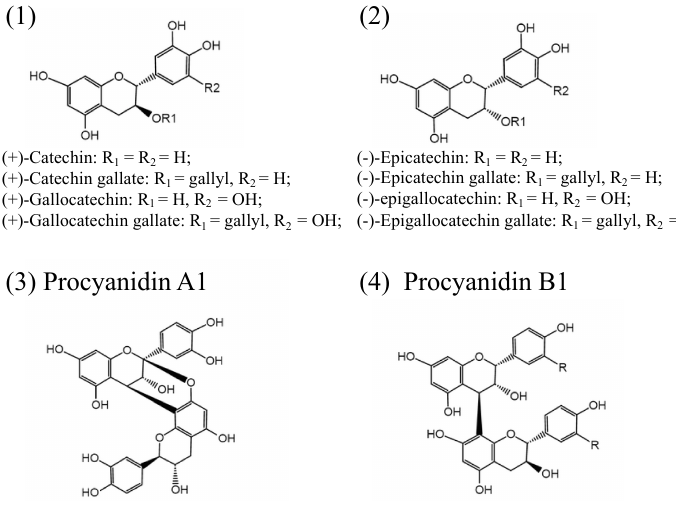
Figure 1. Structures of the flavan-3-ols ( 1 , 2 ); simple A1-type proanthocyanidins ( 3 ); simple B1-type proanthocyanidins ( 4 ).